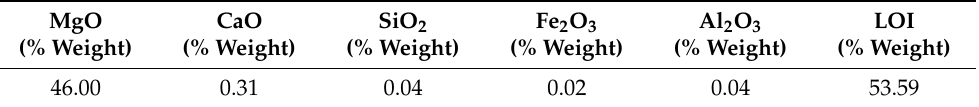
Table 1. Chemical composition of the brucite produced from synthetic brine in Mexico used in the present